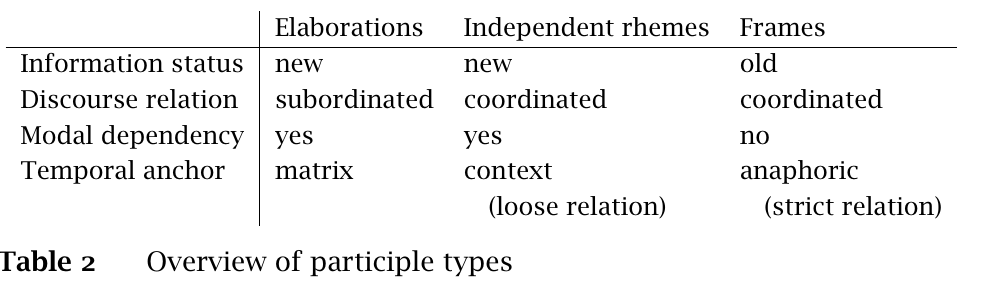
Overview of participle